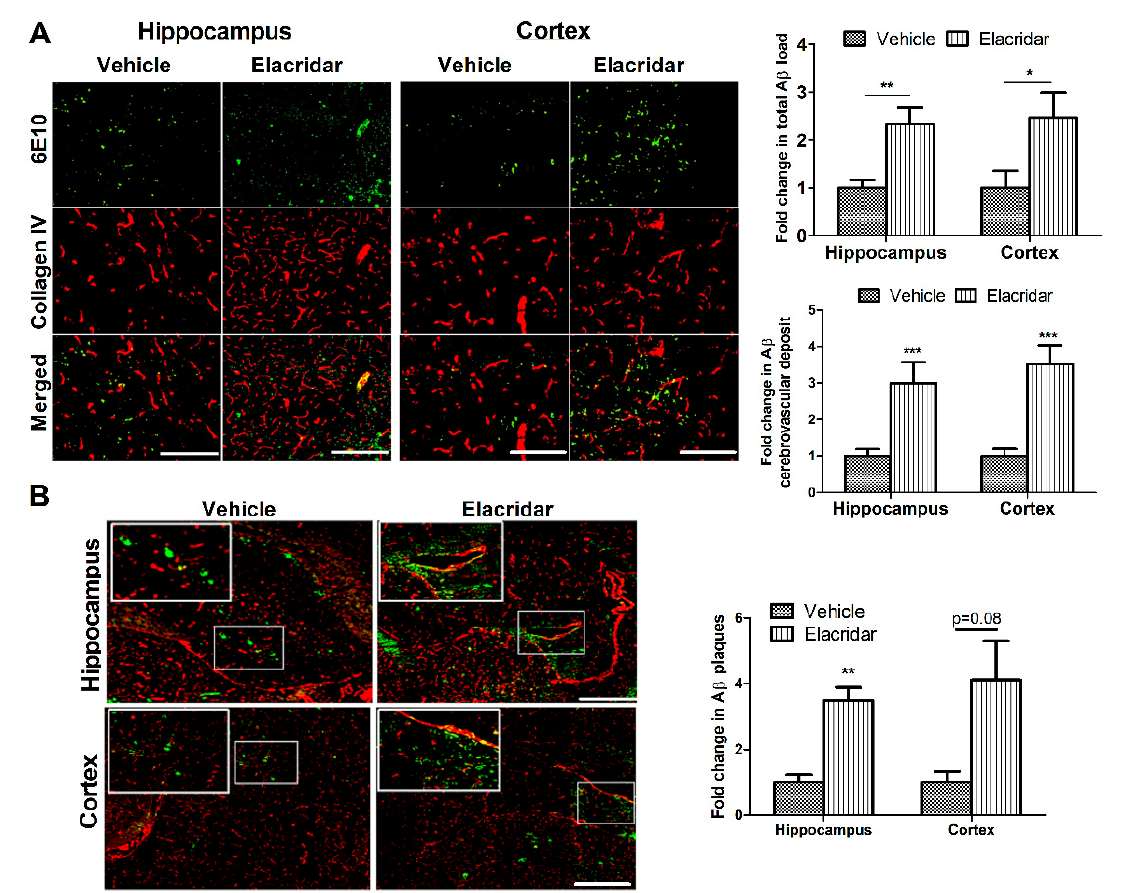
Figure 5. Elacridar treatment increased brain A β burden in the brains of TgSwDI mice. ( A ) Representative brain sections from mice cortex and hippocampus regions stained with 6E10 (green) antibody against A β to detect total A β load and anti-collagen IV (red) to stain microvessels. Semi-quantification analysis of both regions showed a significant increase in parenchymal A β burden and cerebrovascular A β deposit. ( B ) Representative brain sections stained with ThioS (green) and anti-collagen IV (red) to stain microvessels in cortex and hippocampus regions, with the corresponding quantification of the area covered with A β plaques (ThioS). The top white square is a magnification of the small square showing increased A β deposit on the microvessels caused by elacridar. The semi-quantification analysis is presented as fold change caused by elacridar when compared to vehicle treatment. Scale bar = 100 µm. Statistical analysis was determined by Student’s t -test. Data are presented as mean ± SEM of n = 5 mice per group, * p < 0.05, ** p < 0.01, *** p < 0.001 compared to vehicle-treated group.